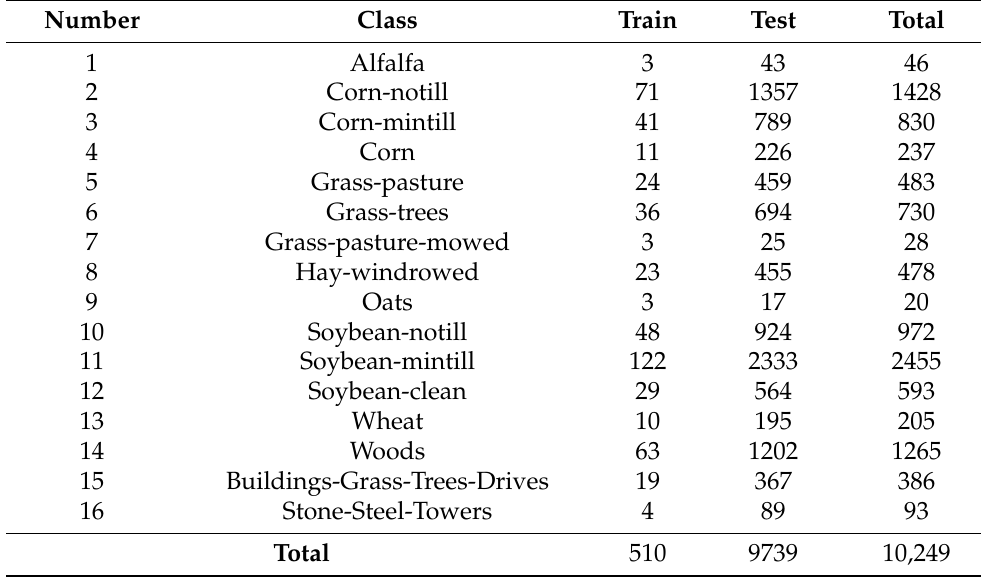
Table 6. The samples for each category of training and testing for the Indian Pines dataset.